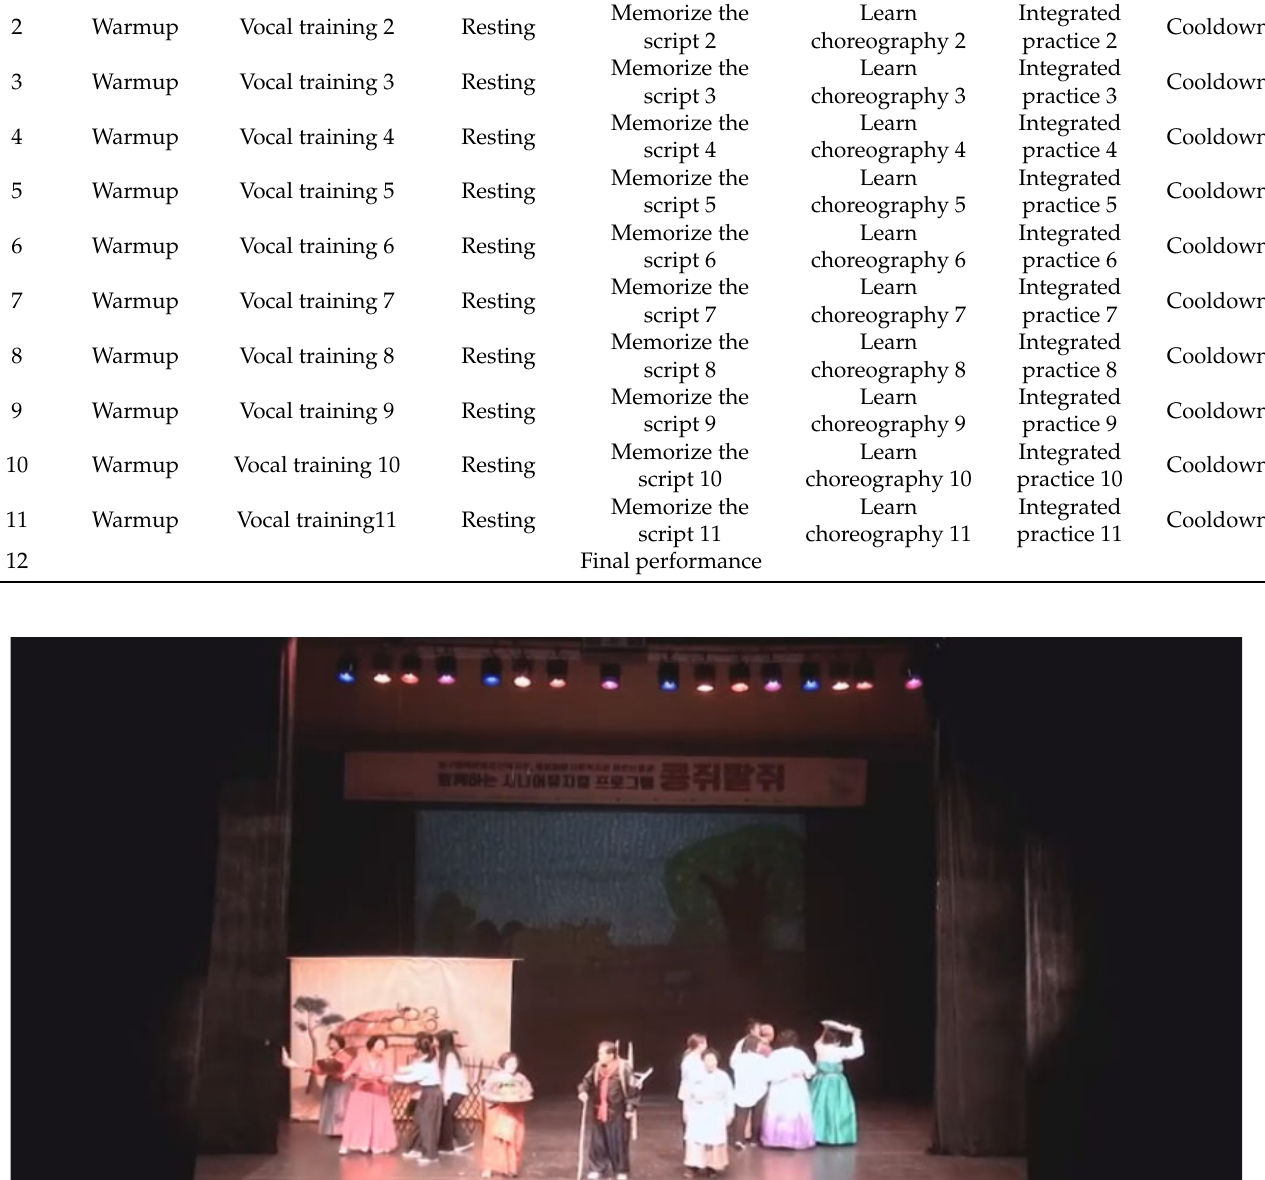
Table 2. Senior musical program.